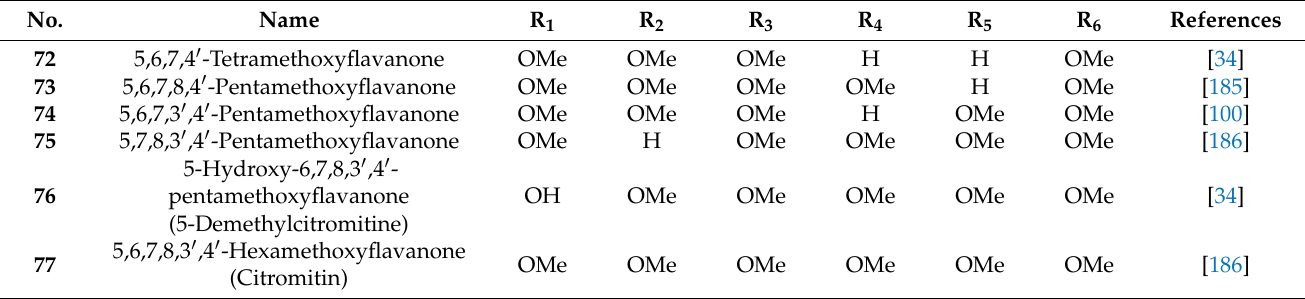
Table 12. Chemical structure of polymethoxyflavanones ( 72–77 ) isolated in genus Citrus .